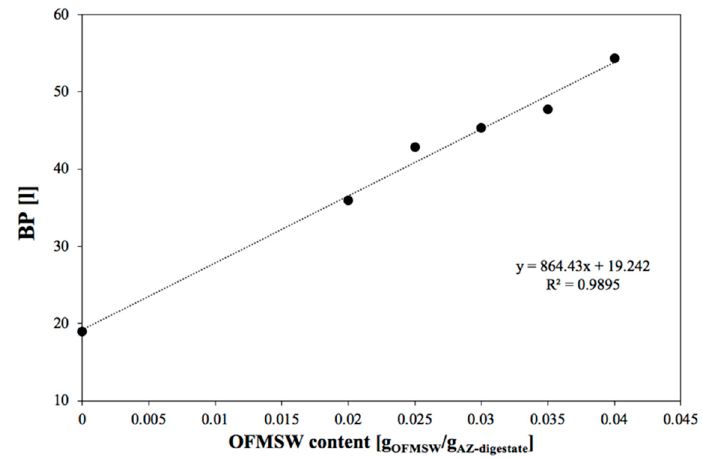
Figure 5. Effect of OFMSW content on biogas productivity during batch wet-AD.